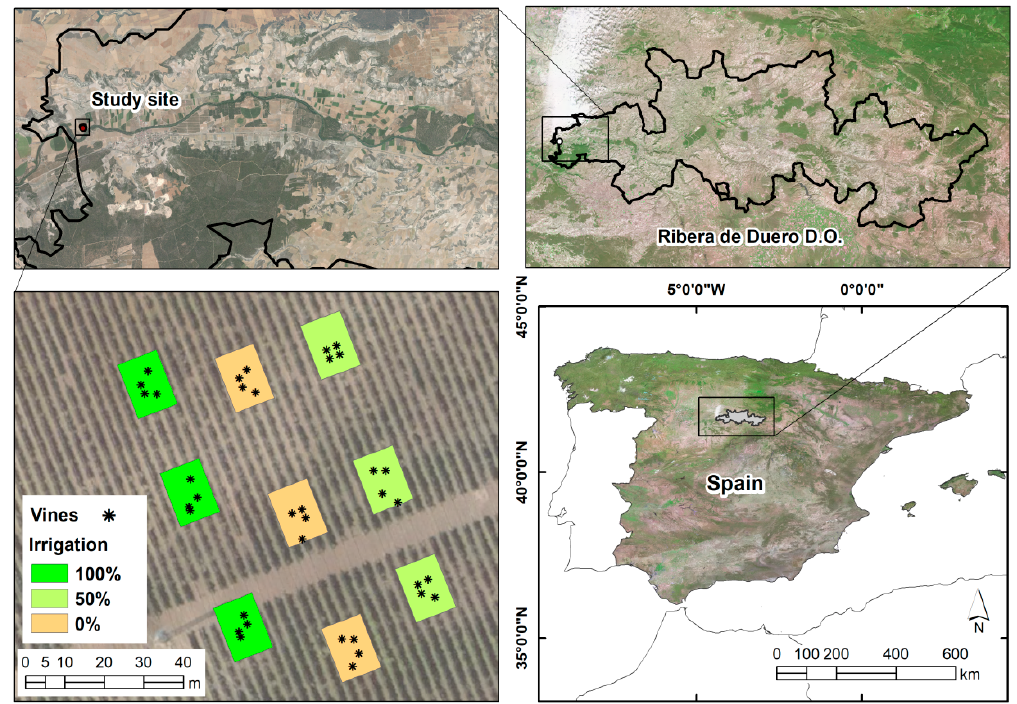
Figure 1. Study vineyard showing blocks and vine locations. D.O.: Ribera de Duero Designation of Origin.